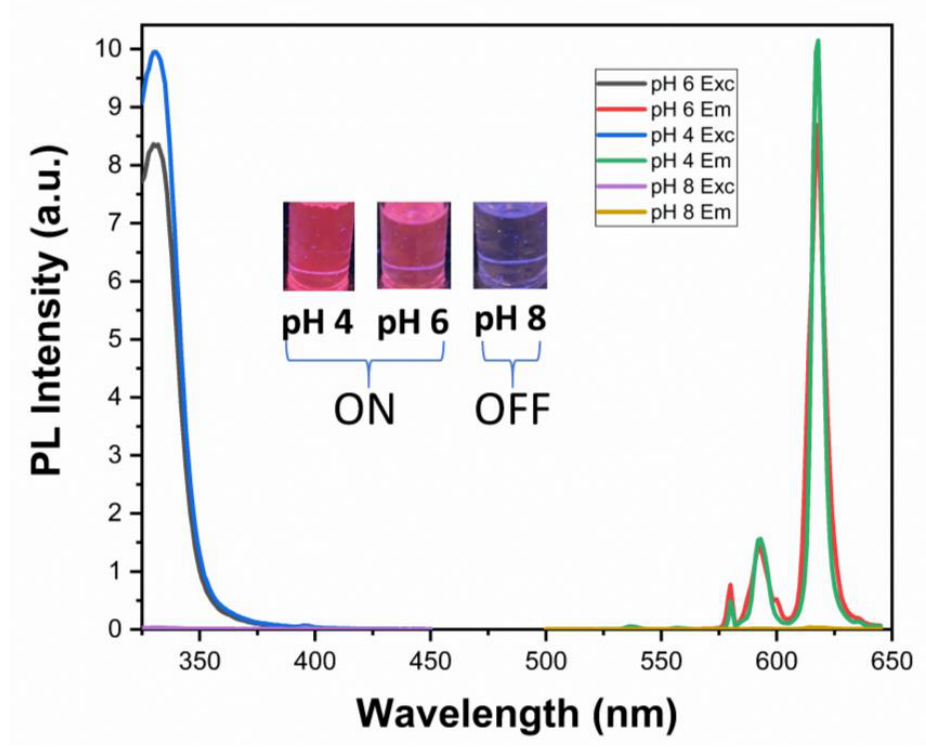
Figure 2. Photoluminescence spectra of K[Eu(hfa) 4 ] in solution at pH 4, 6, and 8. Right traces (λ > 500 nm) show emission spectra dominated by the sharp 5 D 0 → 7 F J atomic Eu(III) emission lines, while left traces ( λ < 450 nm) show excitation spectra dominated by the broad hfa ligand-based transitions. Inset shows emission pictures under UV light irradiation at respective pH values. To evaluate the “on–off” emission changes with respect to pH, cyclic voltammetry (CV) studies were performed. Such CV investigations can determine the changes in the oxidation state of the complex at different pH values because Eu(II) from the metal reduction process is known to be non-emissive [46] or weakly emissive specially in methanol medium [47]. Also the oxidation of Eu 2+ to Eu +3 is reported in acidic media in aqueous solution [47]. Thus, the CV experiment was performed to confirm the changes in the oxidation state of the Eu(III) metal center from 3+ to 2+, with changes in pH from ~5.6 to 8.0. Figure 3a,b show oxidation and reduction cycles of the initial complex at pH 5.6 and complex in alkaline medium (pH 8), respectively. The initial complex only shows reduction as expected, changing its oxidation state 3+ to 2+ (Figure 3a), while the complex in alkaline medium shows only oxidation (Figure 3b). This shows that the complex in alkaline medium exhibits a lower oxidation state compared to the initial complex, which is +2. This was confirmed by the weak emission detected at 468 nm for the complex in alkaline medium, which is in the signature blue emission region for Eu 2+ [48–50] (Figure S1). These data suggest that the Eu 3+ center undergoes a chemical reduction to Eu 2+ in alkaline media, triggering ligand dissociation due to the reduced Columbic attraction. The in situ Eu 2+ generation is responsible for the quenched red